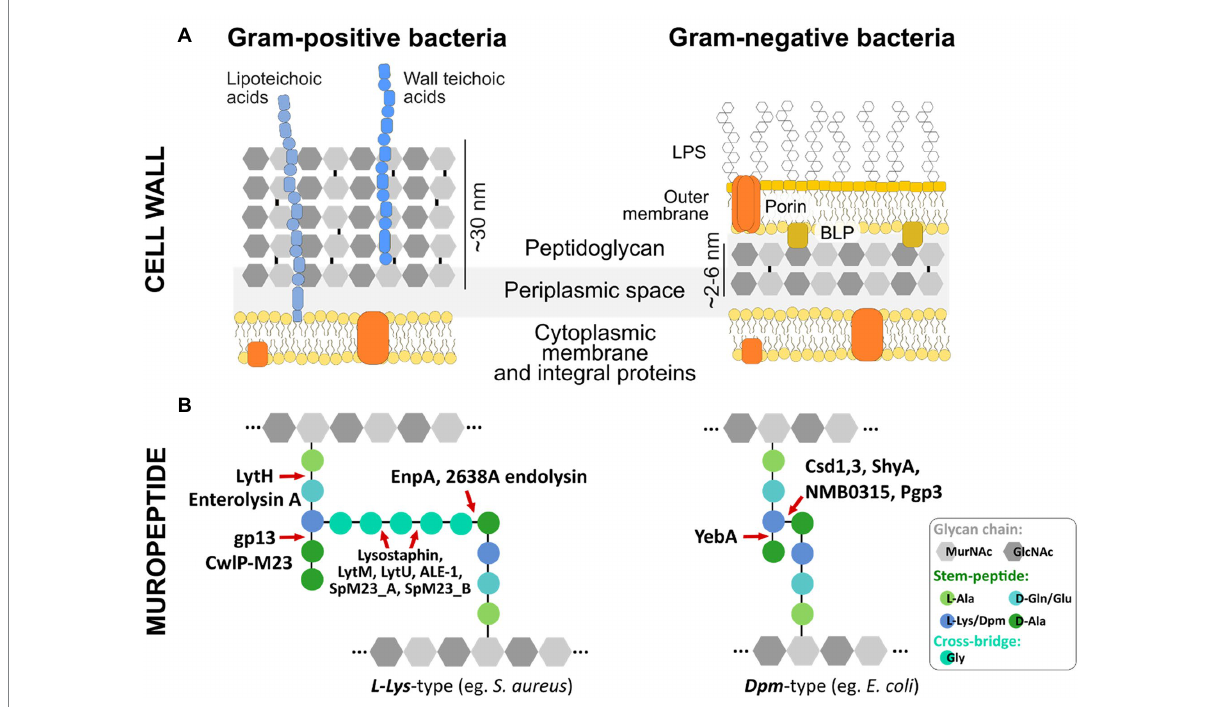
FIGURE 1 Bacterial cell wall architecture, peptidoglycan composition, and M23 hydrolytic enzymes dedicated to different bonds in PG structure (A) Schematic representation of Gram-positive and Gram-negative bacteria cell wall. (B) Basic building blocks and crosslinking of peptidoglycan layer depicted for representative species of Gram-positive (e.g., S. aureus ) and Gram-negative (e.g., E. coli ) bacteria. M23 peptidases are presented as enzymes dedicated to cleaving specific bonds in peptidoglycan structures of both L-Lys -type and Dpm -type peptidoglycan. Glycan chains of N-acetylmuramic acid (MurNAc) and N-acetylglucosamine (GlcNAc) are depicted as gray hexagons; integral membrane proteins are colored in orange; D- and L-amino acids and Dpm ( meso -diaminopimelic acid) characteristic for the stem peptide and cross-bridge are presented as colored circles; LPS, lipopolysaccharides; BLP, Braun’s lipoprotein (Vollmer et al.,